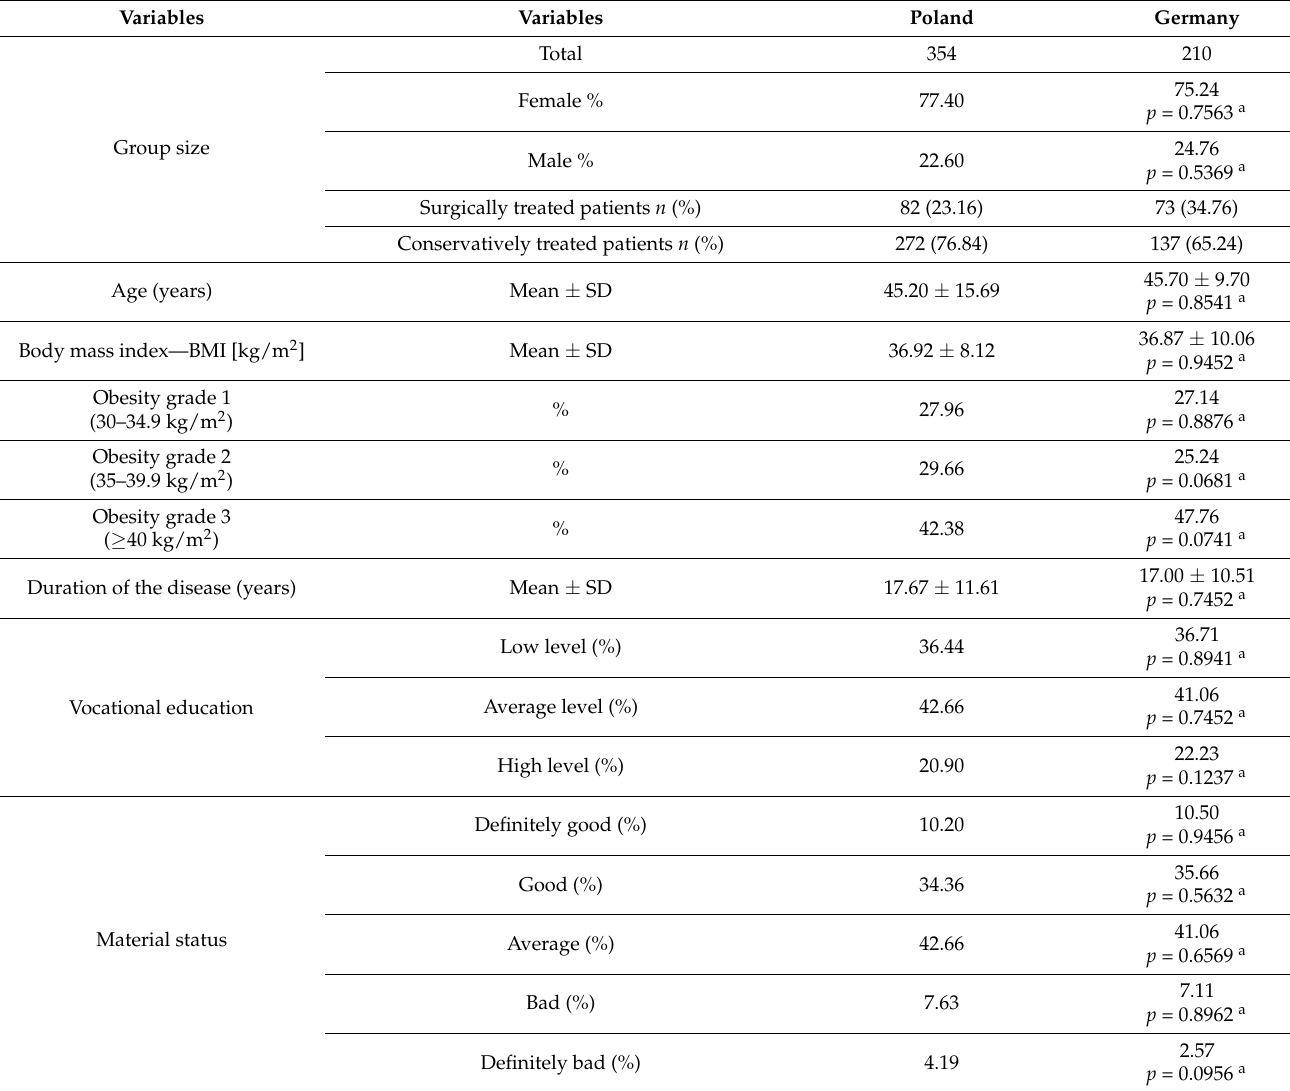
Table 1. Sociodemographic and clinical parameters of obese patients from Poland and Germany ( n =